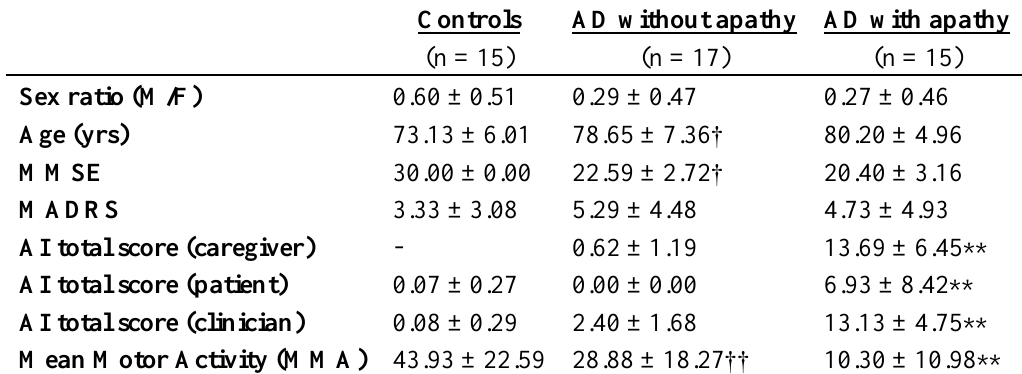
Table 4. 75 mn - Actigraphic parameters (mean ± SD) for AD patients (with and without apathy) and for a control group. Comparison between AD patients without apathy vs. AD patients with apathy (Mann-Whitney U-Test: p < 0.05 *, p < 0.01 **) and AD patients without apathy vs. Controls (Mann-Whitney U-Test; p < 0.05 † , p < 0.01 †† ). Mean motor activity in arbitrary actigraph units.